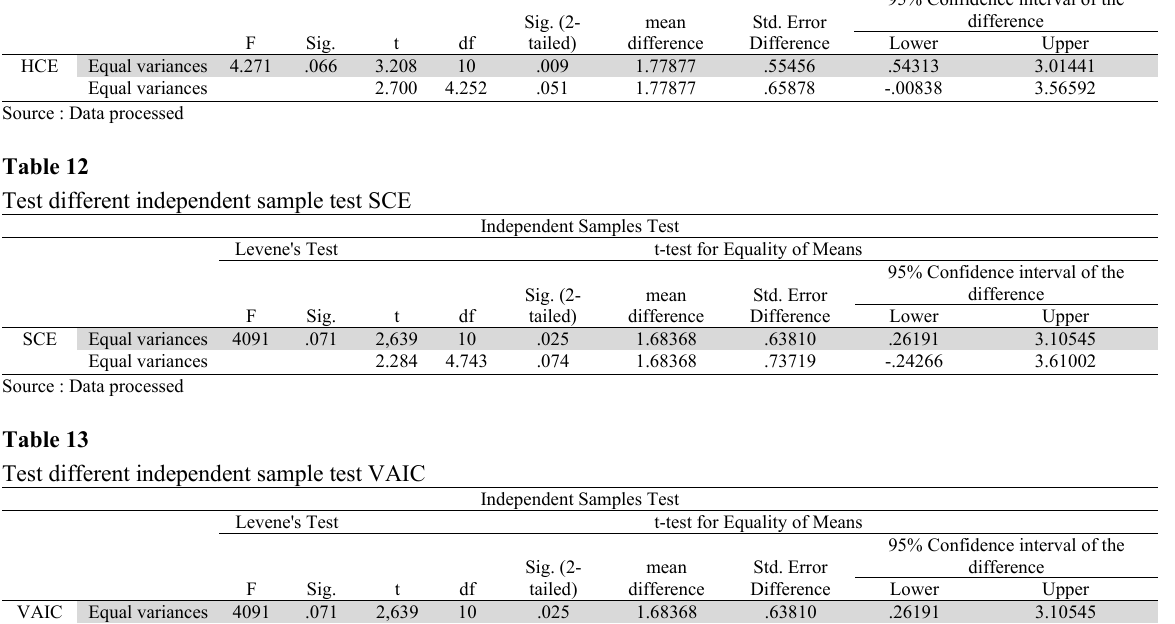
Test different independent sample test HCE Levene's Test t-test for Equality of Means F